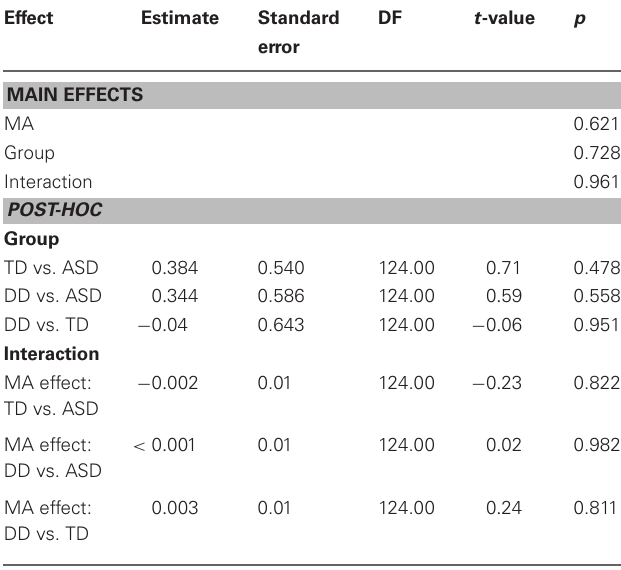
Table 8 | Grip force at onset of load force and mental age (MA).